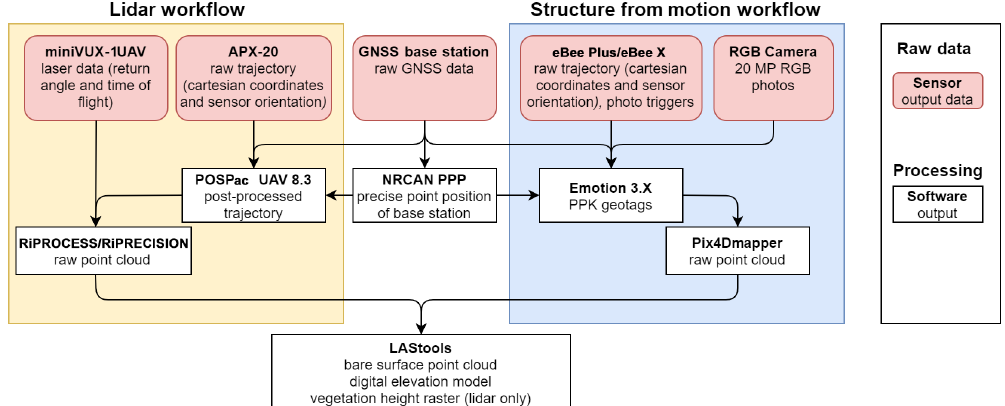
Figure 3. Data processing workflows for lidar and SfM point cloud